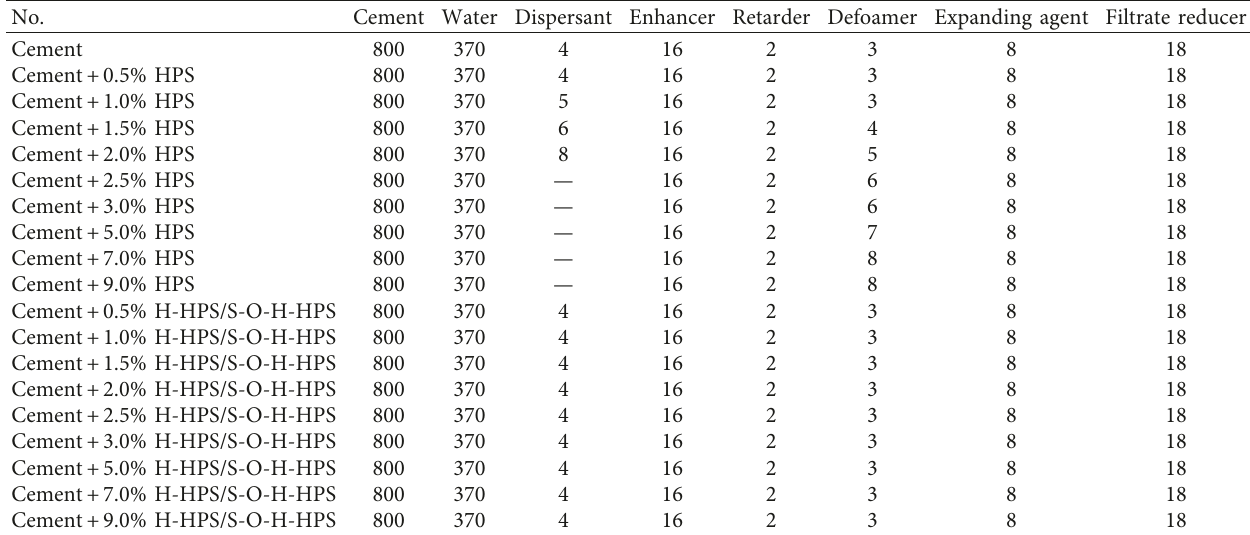
Table 2: Slurry components of different modified sepiolite